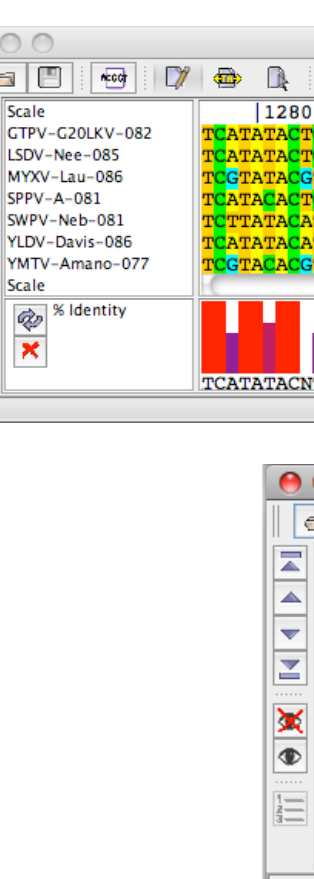
Figure 7. DNA and protein alignments of a super-conserved region in the VETF gene